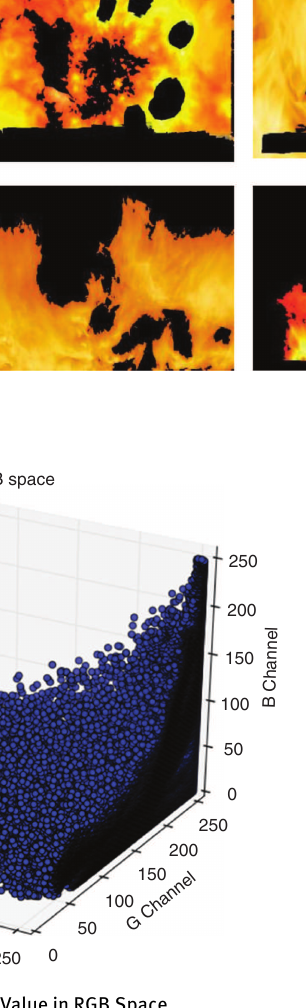
Figure 4: Distribution of Pixel Color Value in RGB